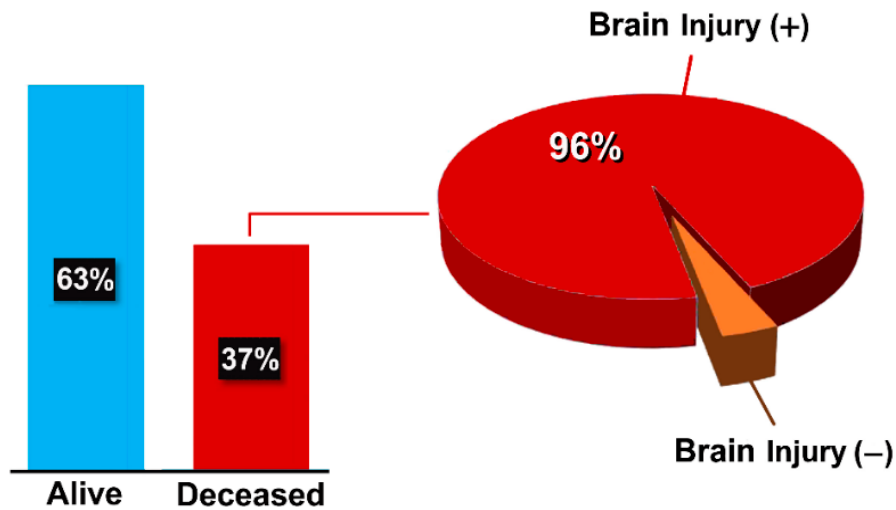
Figure 5. Clinical outcome in the patient population ( n = 426). Brain injury was described as cerebral edema, hematoma, hemorrhage, and/or infarction, often associated with thrombocytopenia.